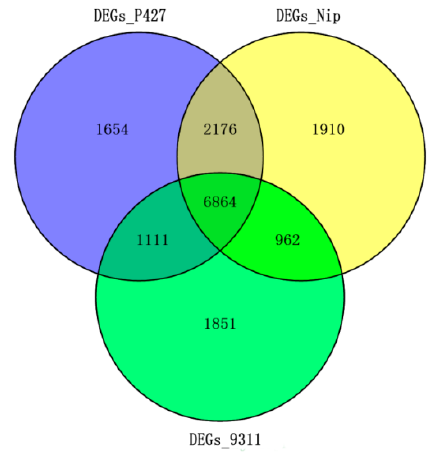
Figure 5. Venn diagram of differentially expressed genes (DEGs) in P427, NIP, and 9311.